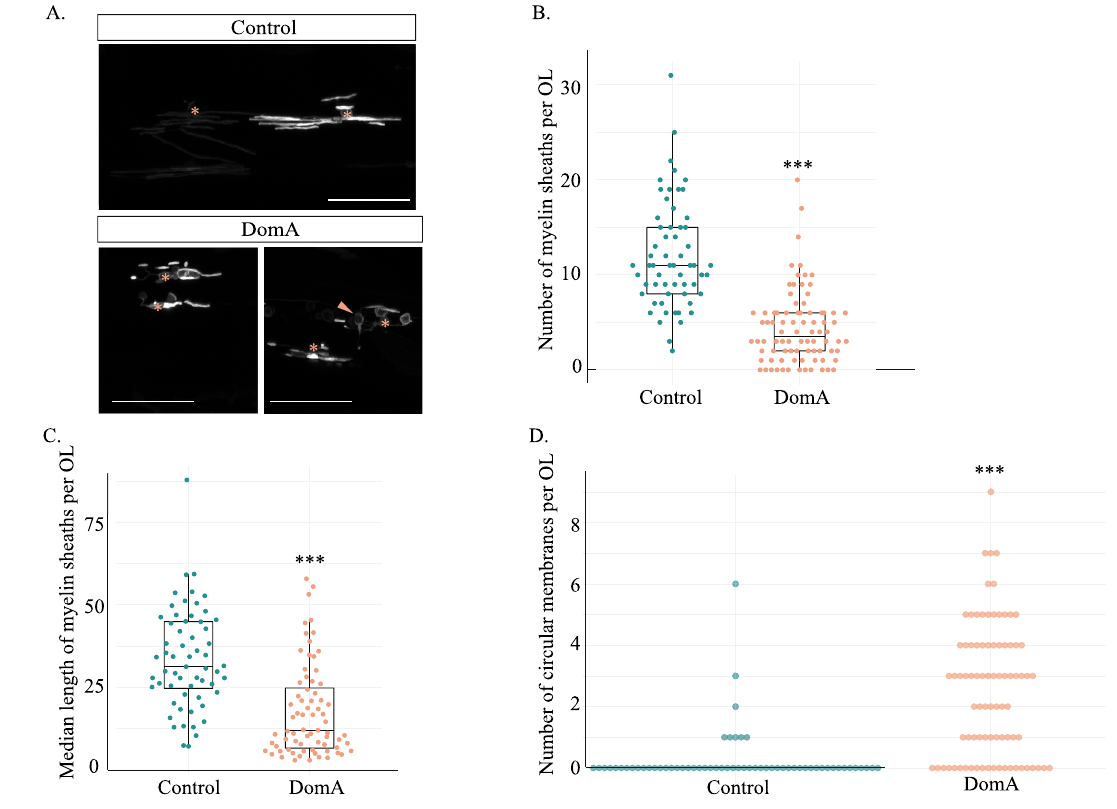
Figure 3. DomA reduces the length and number of myelin sheaths produced by individual oligodendrocytes by 4 dpf. ( A ) Representative images of mosaically labeled oligodendrocytes in DomA-exposed (2 dpf injected) and control fish following 1–4 cell injections of the reporter construct, mbp:EGFP-CAAX into Tg(sox10:RFP) background. Only EGFP channel is presented to show the sparsely labeled myelin sheaths. Asterisks mark oligodendrocyte cell bodies. Peach arrow points to aberrant circular profiles. Scale bar = 50 μm. ( B ) Number of myelin sheaths produced by single oligodendrocytes (OL) in both control and DomA exposed fish. ( C ) Median length of the myelin sheaths produced by individual OLs in μm. OL without myelin sheaths were excluded from this graph. ( D ) Number of circular myelin membranes produced by individual OLs. *** p < 1